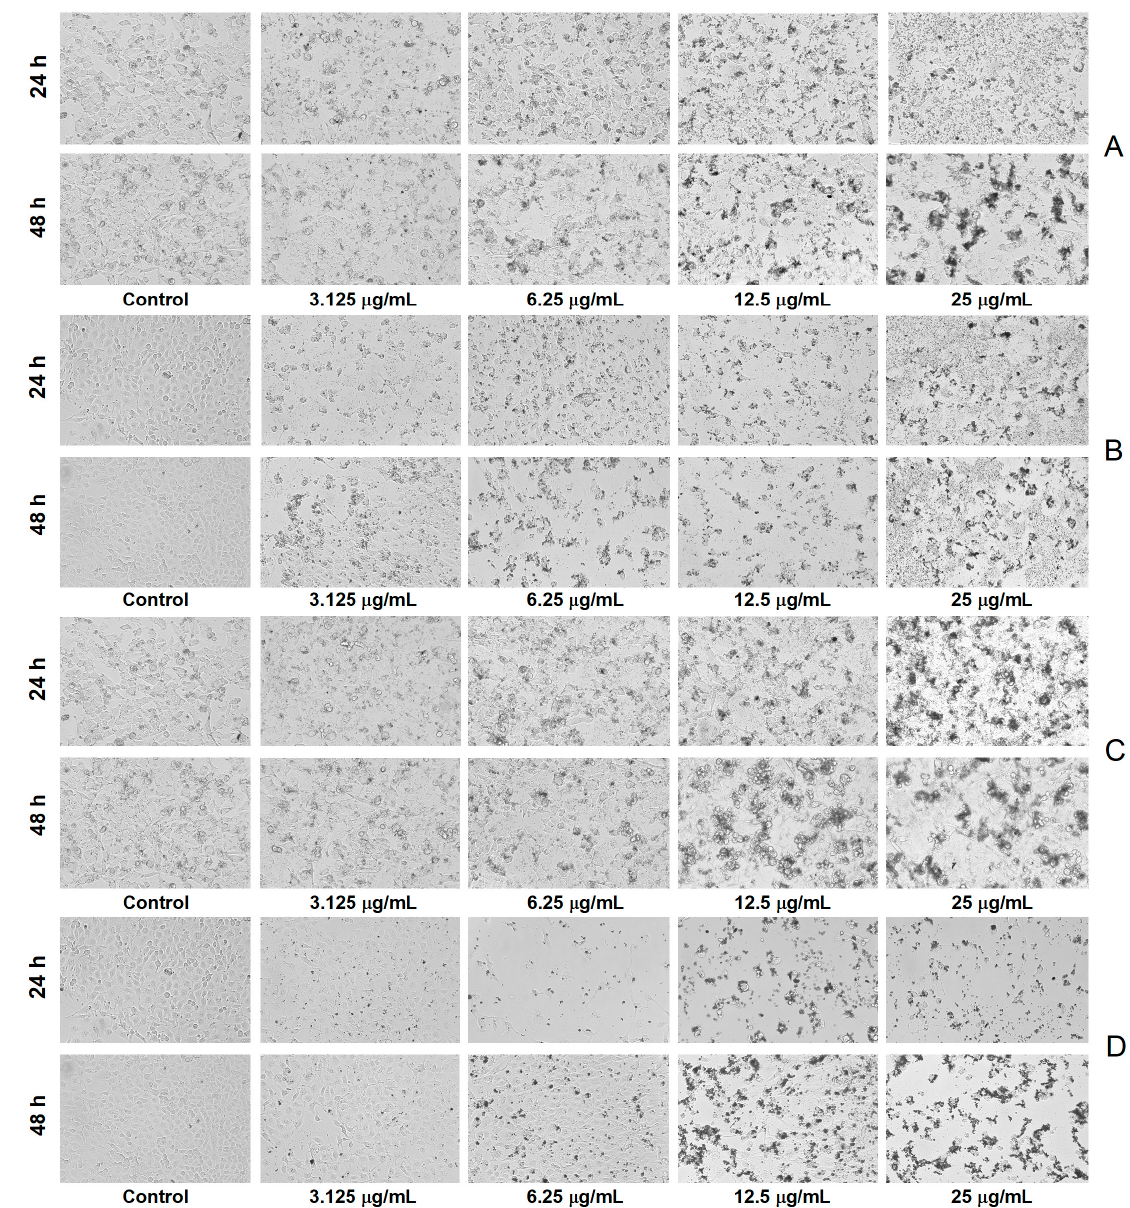
Figure 8. Bright-field morphological aspects of cells exposed to Abies alba bark extract-derived AgNPs (( A )—A-375 human malignant melanoma cells, ( B )—African green monkey kidney (Vero) cells) and Pinus sylvestris bark extract-derived AgNPs (( C )—A-375 human malignant melanoma cells, ( D )—African green monkey kidney (Vero) cells); scale bar 100 µm (10× magni fi cation).